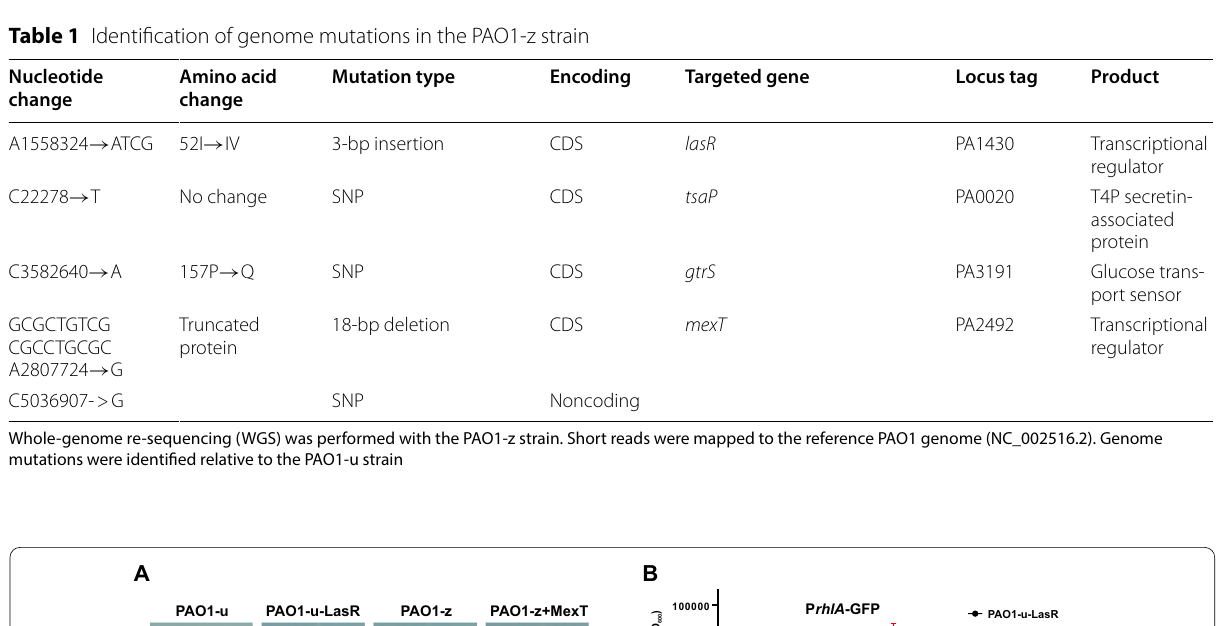
Table 1 Identification of genome mutations in the PAO1-z strain